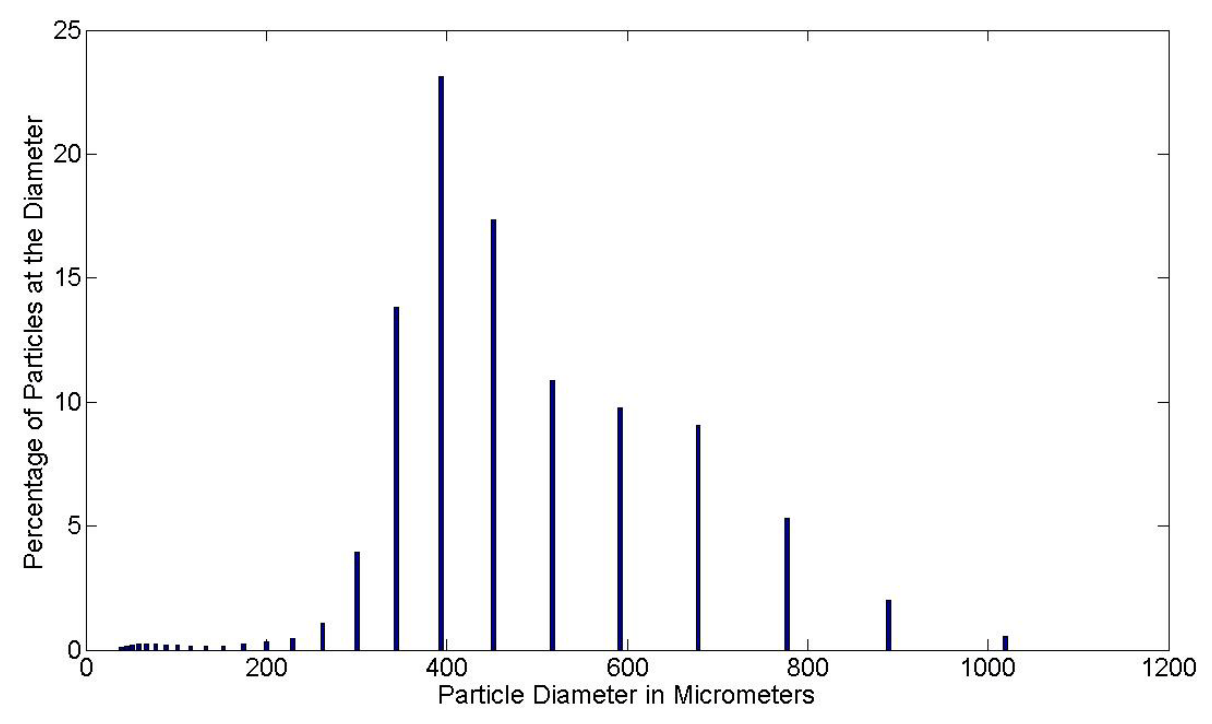
Figure 5. The size distribution of a sample of low density LDPE